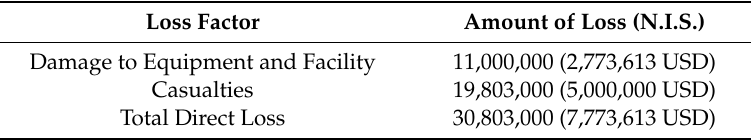
Table 3. Total Direct Loss to